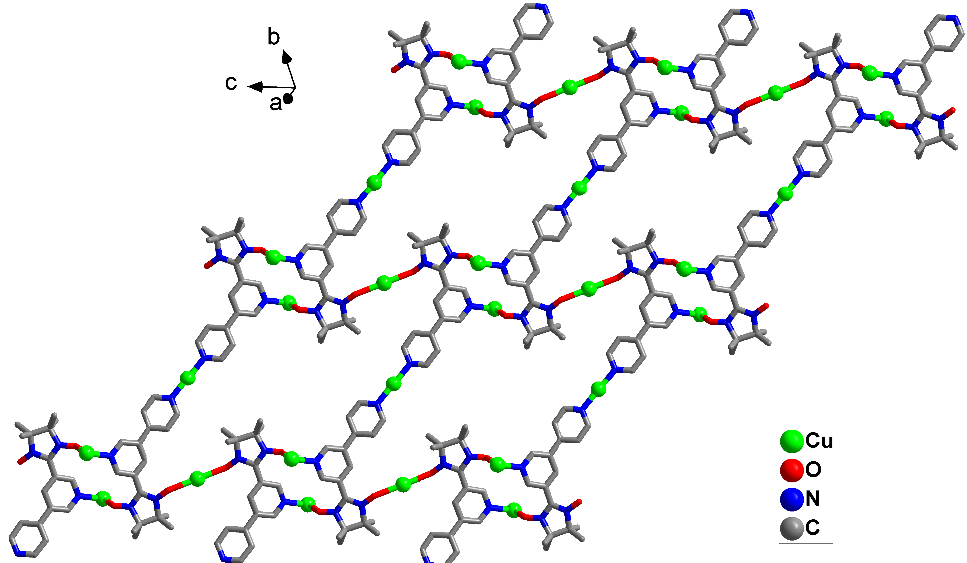
Figure 4. The 2D layer structure of complex 2 . In order to clearly represent the structure, H atoms and the bidentate hfac − are left out.